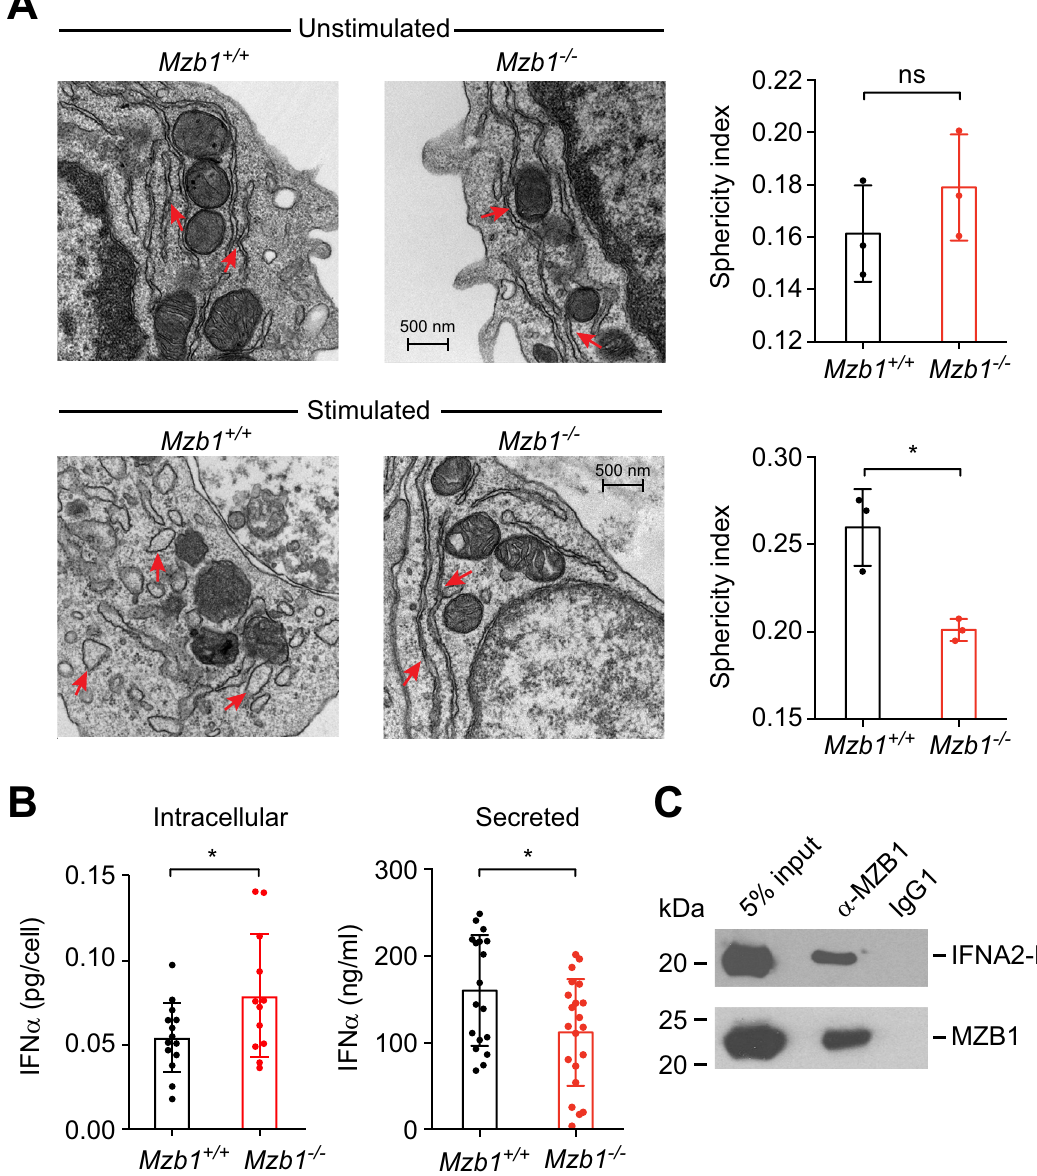
Figure 2. Mzb1 −/− pDCs show a reduced expansion of the ER and intracellular retention of IFNα. ( A ) Electron microscopy (EM) analysis of Mzb1 + / + and Mzb1 −/− pDCs that were unstimulated or stimulated with CpG A for 24 h (left-hand panels). Red arrows indicate the ER. The quantification of the sphericity index of the ER, as the ratio of the width to the length of the ER, is shown in the right-hand panels. Each dot is a biologically separate sample with approximately 50 different cells imaged for each sample. Statistical difference between the mean was analysed by an unpaired two-tailed Student’s t-test. *P ≤ 0.05. Error bars show SD. ns, non-significant. ( B ) Intracellular and secreted IFNα levels of CpG A-stimulated (24hrs) Mzb1 +/+ and Mzb1 −/− pDCs, as determined by ELISA of lysates and supernatants of 10 5 cells, respectively. Each dot represents pDCs derived from the bone marrow of individual mice. Data from two separate experiments were included in the analysis. Statistical difference between the mean was analysed by an unpaired two-tailed Student’s t-test. *P ≤ 0.05, **P ≤ 0.005. Error bars show SD. ( C ) Co-immunoprecipitation assay to detect the interaction of MZB1 with IFNA2. Lysates of K46 B cells expressing HA-tagged IFNA2 were incubated with an anti-Mzb1 monoclonal antibody or an IgG control. MZB1 and IFNA2 were detected by immunoblot analysis with MZB1- and HA-specific antibodies, respectively. Uncropped blots are shown in Supplementary Fig.